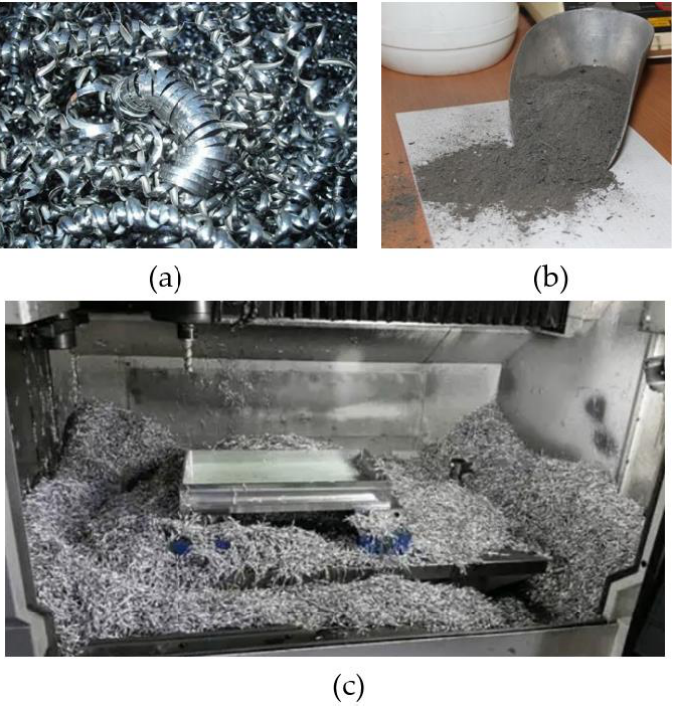
Figure 2. ( a ) Metal scraps from turning; ( b ) metal scraps from grinding; ( c ) metal scraps from milling.